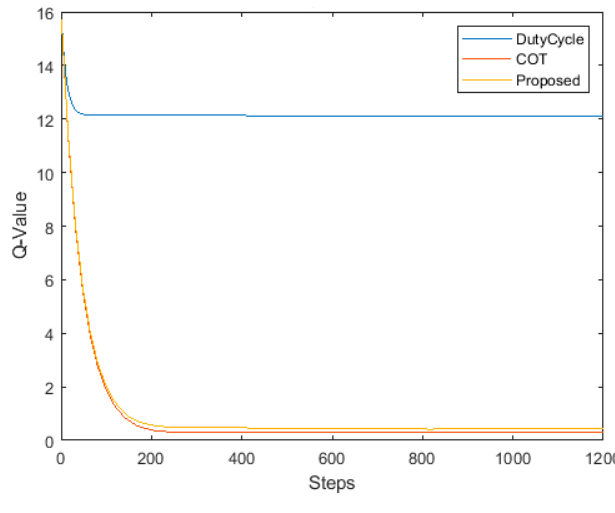
Figure 7. LTE-U BS with proposed method. ( a ) Channel selection vs number of steps; ( b ) Dutycycle selection vs number of steps.